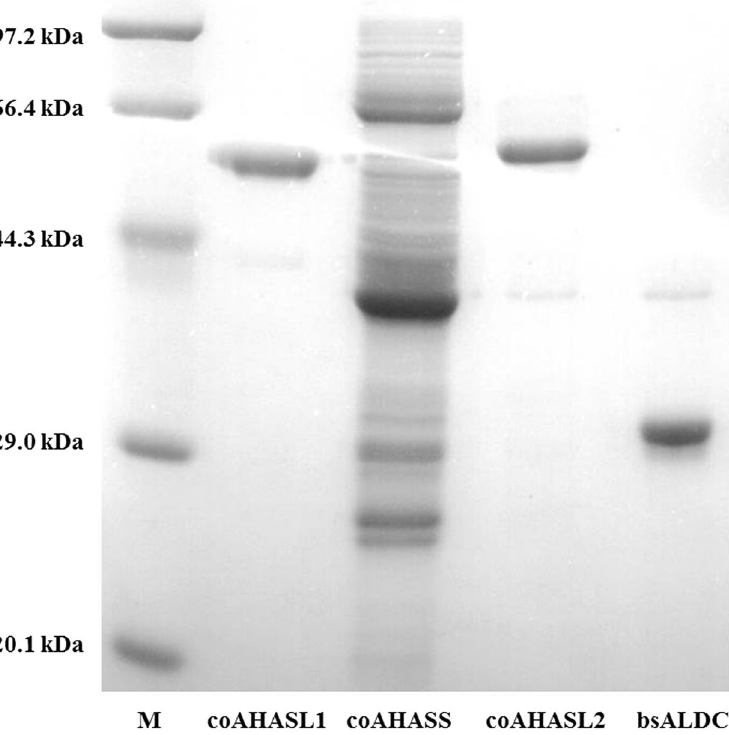
Figure 2. SDS-PAGE analysis of the recombinant enzymes involved in converting pyruvate to